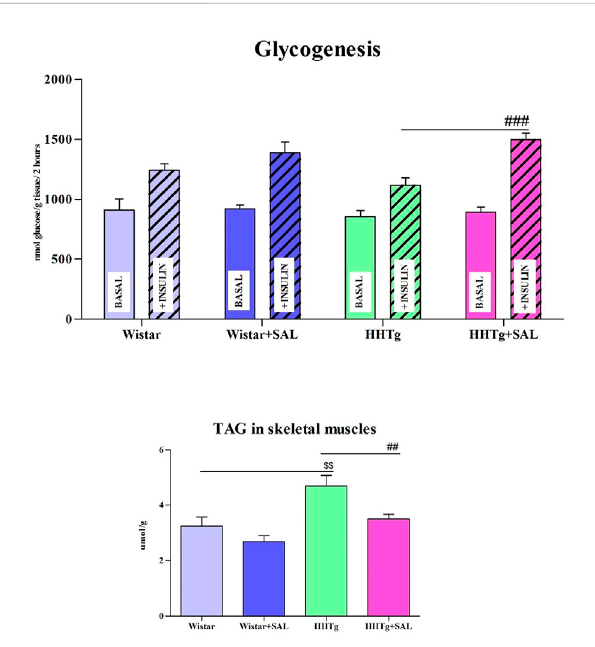
FIGURE 2 Effectofsalsalatetreatmentonparametersofinsulinsensitivityin skeletal muscles. Basal and insulin-stimulated 14 C-U glucose incorporation into glycogen in muscle (glycogenesis) and skeletal muscle triglycerides concentration in Wistar control and hereditary hypertriglyceridemic (HHTg). Values are expressed as mean ± SEM; n = 8; # denotes signi fi cance re fl ecting the effect of HHTg vs. HHTg + SAL, $ denotes signi fi cance re fl ecting the effect of Wistar vs. HHTg; ## p ˂ 0.01, ### p ˂ 0.001; $$ p ˂